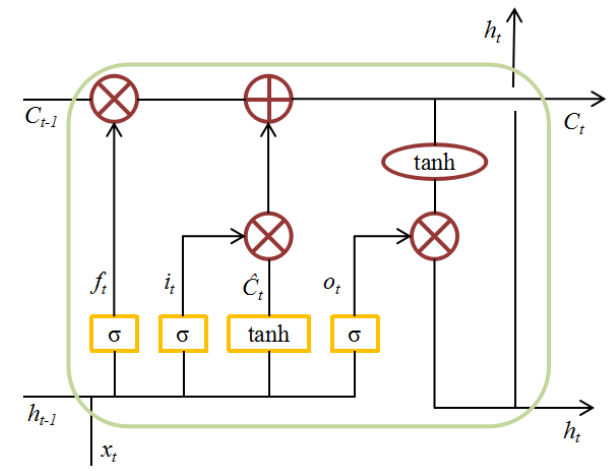
Fig. 4 An example of LSTM